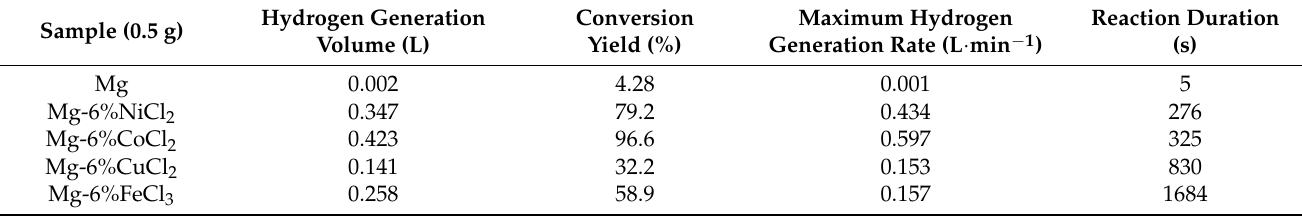
Figure 5. Hydrogen generation curves of the Mg-chloride with water ( a ), the hydrogen generation rate curves ( b ) and the temperature evolution curves ( c ). Table 2. Hydrogen generation properties of ball-milled Mg-chloride with water.